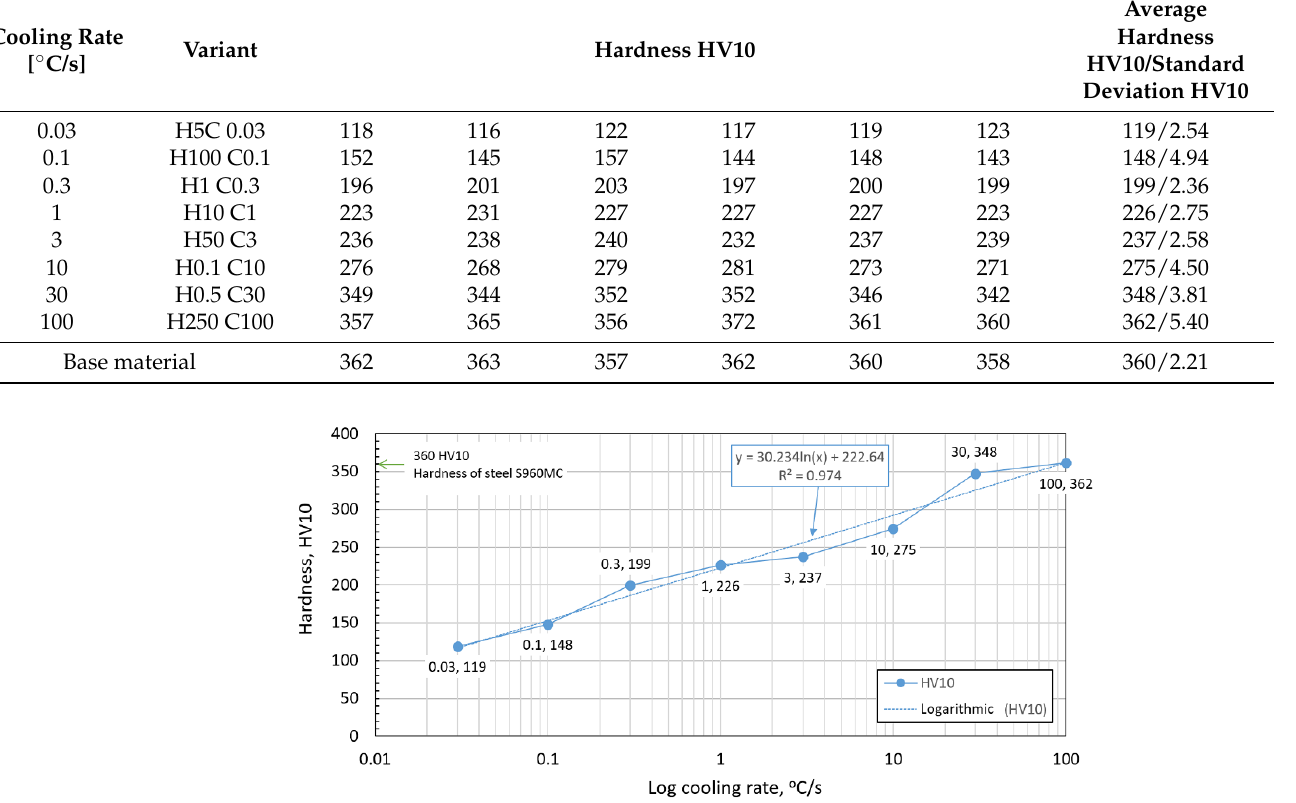
Table 8. The hardness of the final microstructure for different cooling rates.